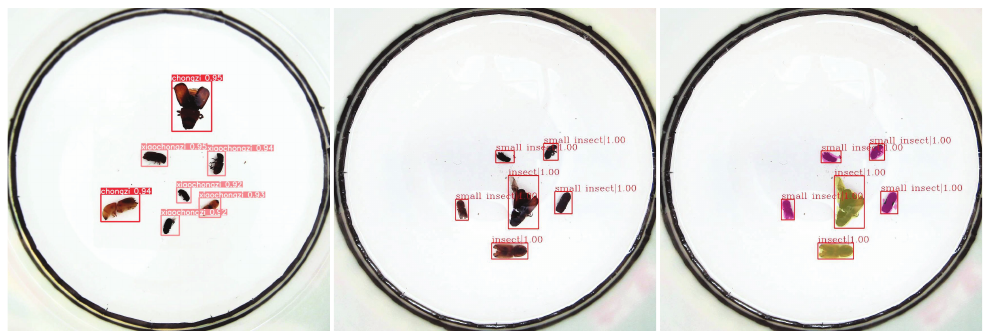
Figure 14. Some examples of the testing results of Yolov5, Faster-RCNN and Mask-RCNN models for insect pest detection.